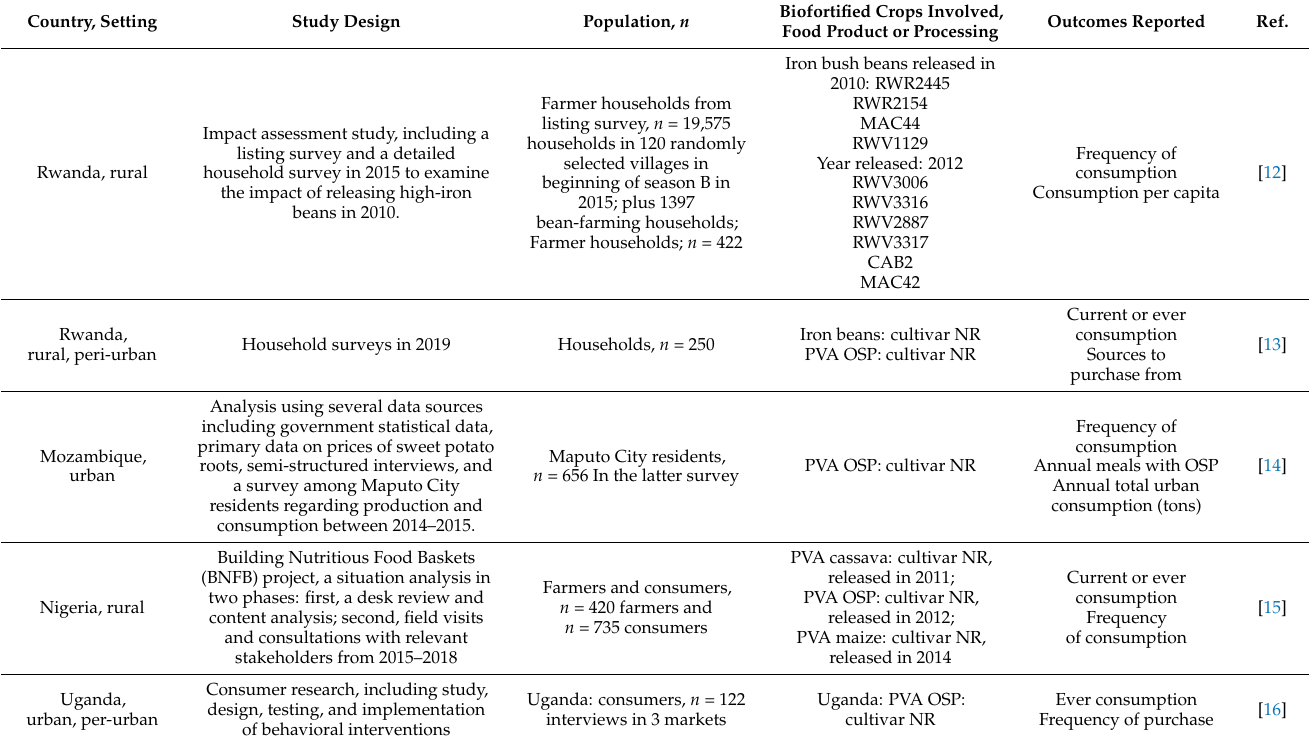
Table 3. Characteristics of included studies for Impact Pathway 1, Direct Purchase and